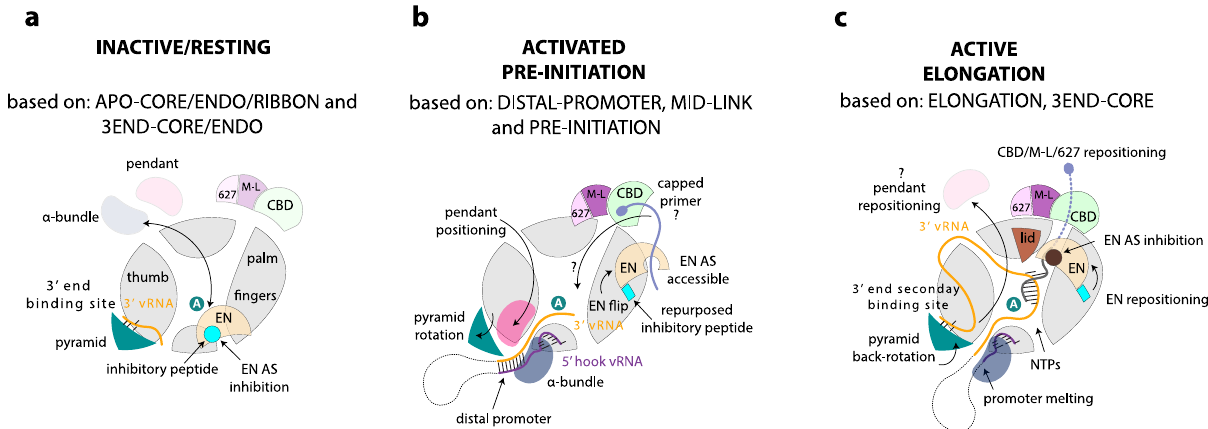
Fig. 7 Schematic diagram of conformational changes in Lassa virus L protein associated with promoter binding and RNA synthesis activity. a On the surface of the inactive/resting L protein core, there is mutually exclusive positioning (black double-arrow) of either the α -bundle and pendant (APO- RIBBON structure) or the EN domain (APO-ENDO, 3END-ENDO structures). When placed on the core, the inhibitory peptide (cyan) autoinhibits the EN domain by binding in its active site. In the absence of the 5 ′ vRNA, the 3 ′ vRNA binds preferentially, base-speci fi cally, into a distinct secondary 3 ′ RNA binding site between the pyramid and thumb domains (3END-ENDO/CORE structures). b Upon full promoter binding, major conformational changes occur (based on PRE-INITIATION, DISTAL-PROMOTER, MID-LINK structures). The 5 ′ end nucleotides 0 – 9 are bound in a hook-like conformation in a speci fi c pocket outside the active site. The distal promoter (formed by 3 ′ and 5 ′ vRNA nucleotides 12 – 19) is positioned by tight association with the α -bundle and pendant, with concomitant rotation of the pyramid domain. This forces release of the 3 ′ vRNA from the secondary binding site, allowing it to be directed towards the RNA synthesis active site (marked by the white A in the teal circle). Positioning of the pendant domain next to the distal promoter displaces the EN domain, which relocates to the other end of the L protein core with the inhibitory peptide contacting its surface leaving the EN active site accessible. In this con fi guration, the EN is presumed to be in close vicinity to the CBD-like domain and could potentially cleave an incoming capped RNA to generate a transcription primer by ‘ cap-snatching ’ . How the capped primer associates with the CBD-like domain and how it is navigated towards the active site to initiate transcription remains elusive. c Upon transition to the elongation state, the distal promoter duplex melts and the pendant domain is released, which allows the pyramid to rotate back and re-establish the availability of the secondary 3 ′ end binding site (ELONGATION structure). We presume the 3 ′ vRNA template, after exiting the active site, wraps around the L protein core and rebinds to the secondary 3 ′ end binding site, as described for in fl uenza virus polymerase complex 18 . The EN repositions once again and together with the mid-link and CBD-like domains form a highly structured ring around the putative product exit channel. The EN active site is again autoinhibited, this time by the relocation of its C-terminal helix (181 – 188) to the active